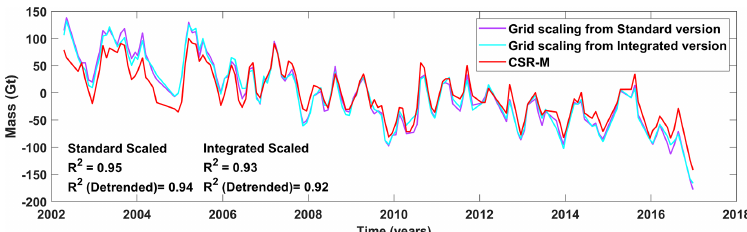
Figure 15. Comparison of basin-averaged time series from grid-scaled GRACE SH using standard, and integrated WGHM with basin- averaged time series from CSR-M.